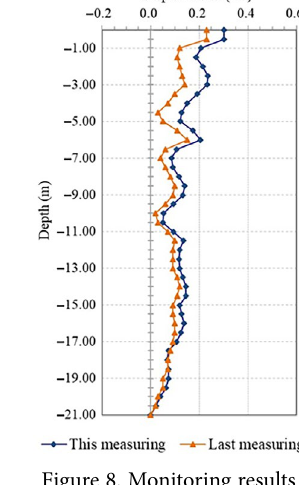
Figure 8. Monitoring results